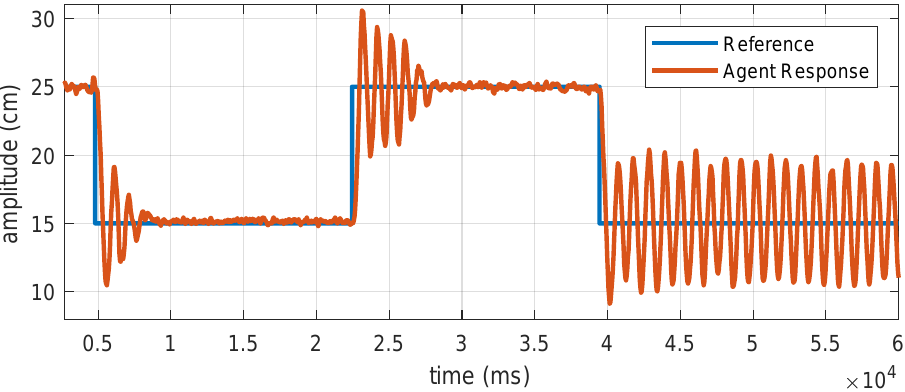
Figure 11. Plots for the Ziegler-Nichols second method experiments with a single PL-TOON